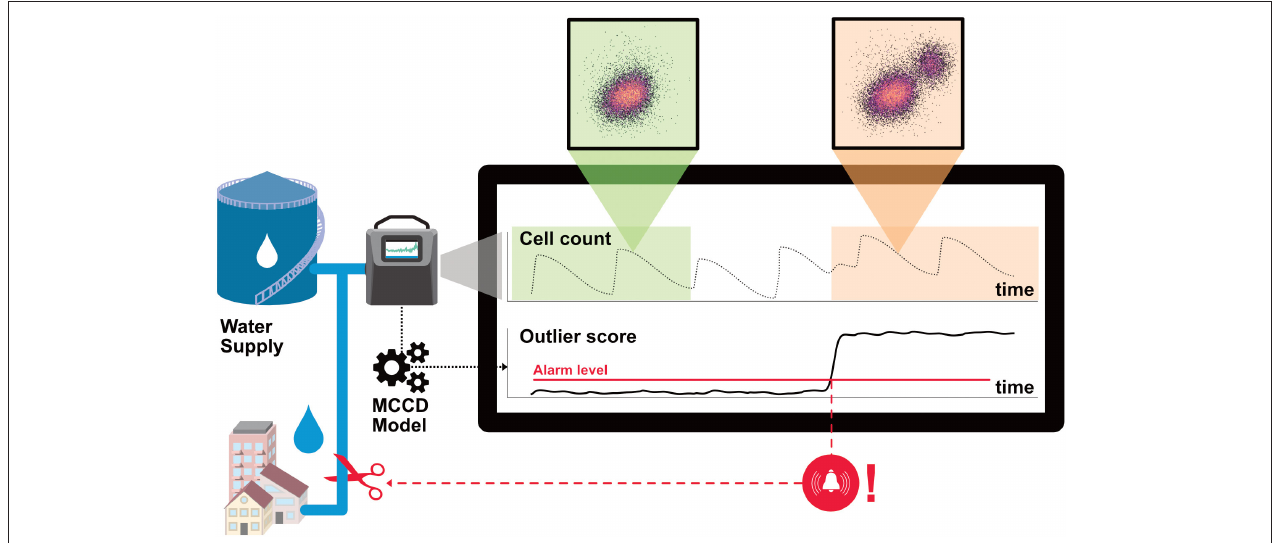
FIGURE 1 | FCM online monitoring in a water process subjected to daily fluctuations and illustration of the outlier score. Bacterial anomalies that manifest by an additional cell population might be easily seen in the dot plot by an operator, but not in the reported cell concentration. Our Microbial Community Change Detection outlier model (MCCD) overcomes this limitation by comparing the event distribution of the online measurements to a reference period and can thus contribute to fast anomaly